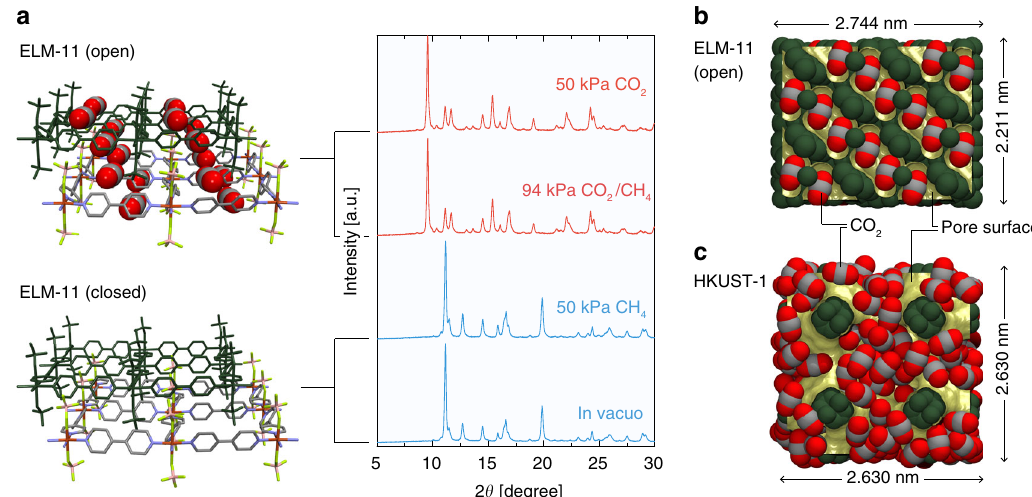
Fig. 4 Framework structures of ELM-11 and HKUST-1. a In situ X-ray powder diffraction patterns (Cu K α ) of ELM-11 in vacuo and after adsorption of CO 2 gas (50 kPa), CH 4 gas (50 kPa), and an equimolar CO 2 /CH 4 gas mixture (94 kPa) at 273 K together with crystal structures of ELM-11 in closed and open states determined in our previous studies 23,26 . Pore structure and CO 2 con fi guration of b ELM-11 and c